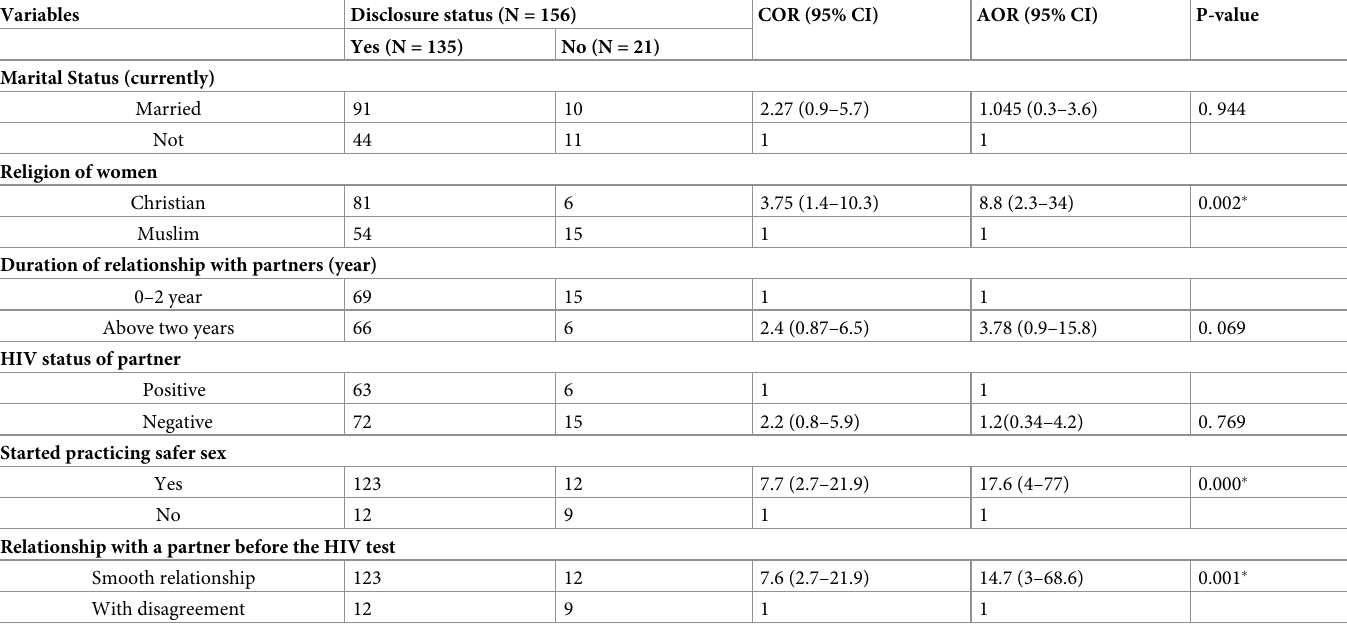
Table 4. Factors associated with HIV-positive status disclosure to sexual partner among PMTCT attendees women in public health facilities in Dire Dawa, 2020, (n =